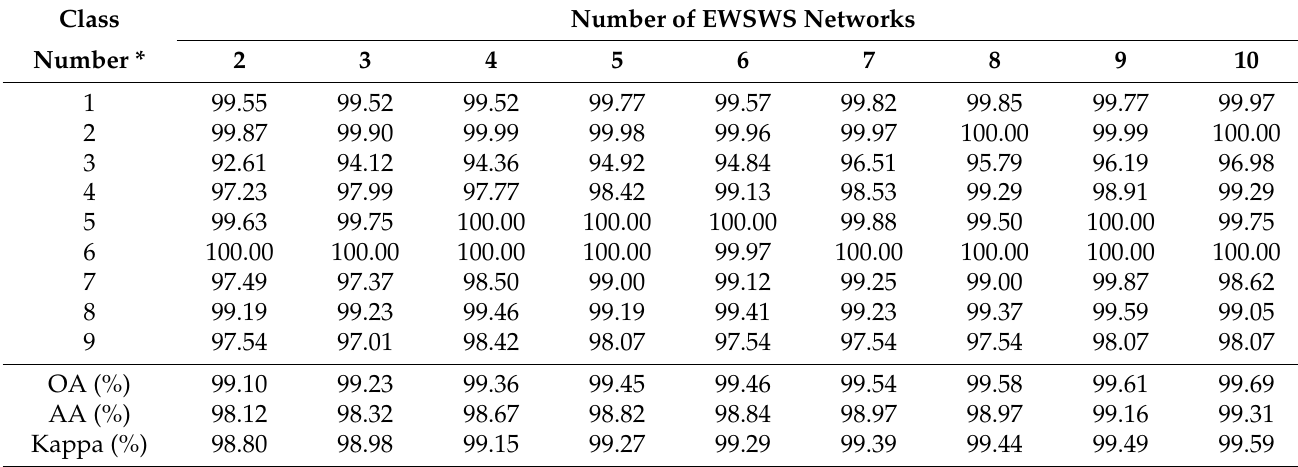
Table 7. Classification results with different numbers of EWSWS networks with the Pavia University